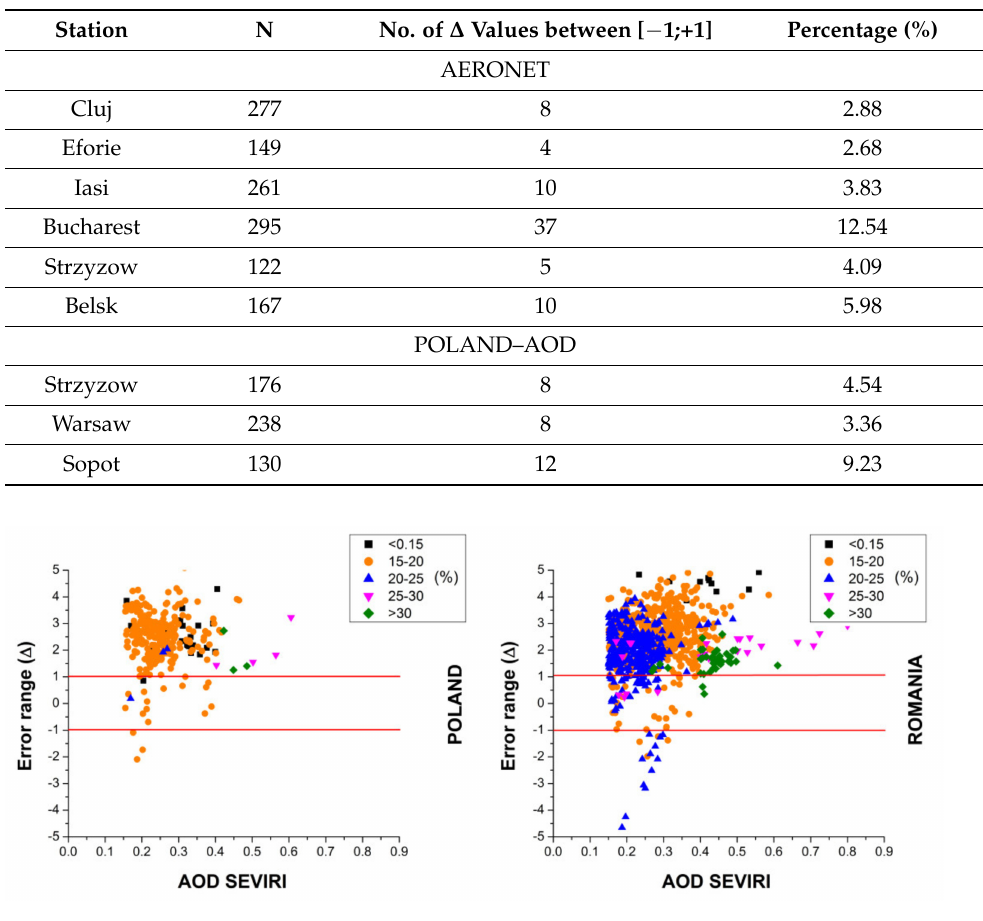
Figure 4. Expected error distribution versus SEVIRI AOD values for Poland ( left ) and Romania ( right ). Uncertainty thresholds, <15 to >30 (%) are represented by different coloured